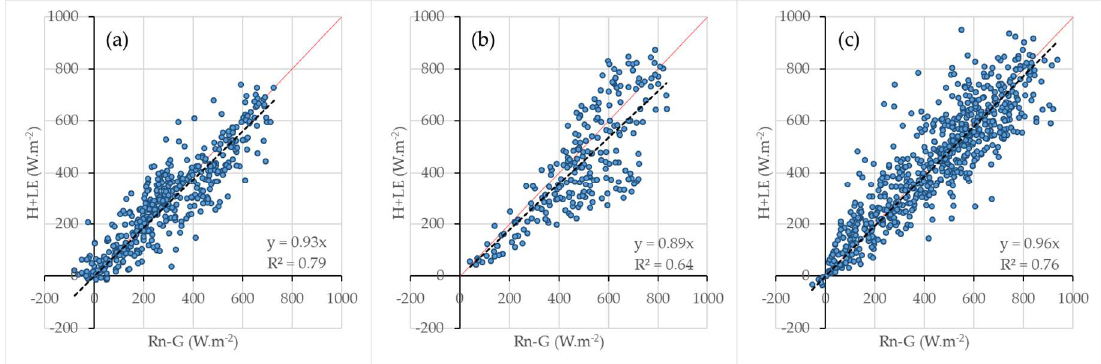
Figure 2. Comparison between turbulent energy fluxes (H + LE) and available energy (Rn − G) from the eddy covariance systems for daytime period (8:00–18:00) at ( a ) USR, ( b ) PDG, and ( c ) RECOR flux towers, for METRIC processing dates. The red line represents the 1:1 relation.